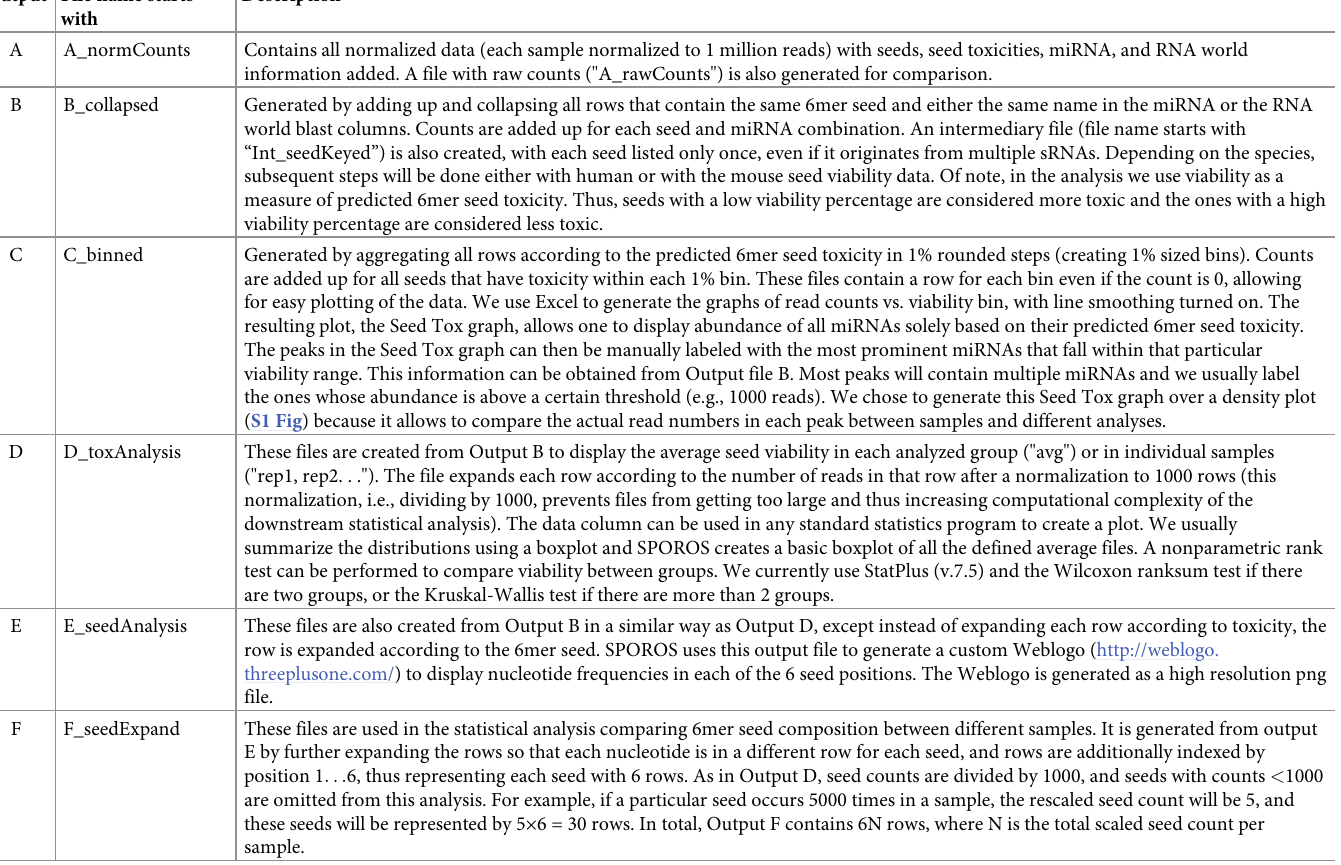
Table 1. Main output files of